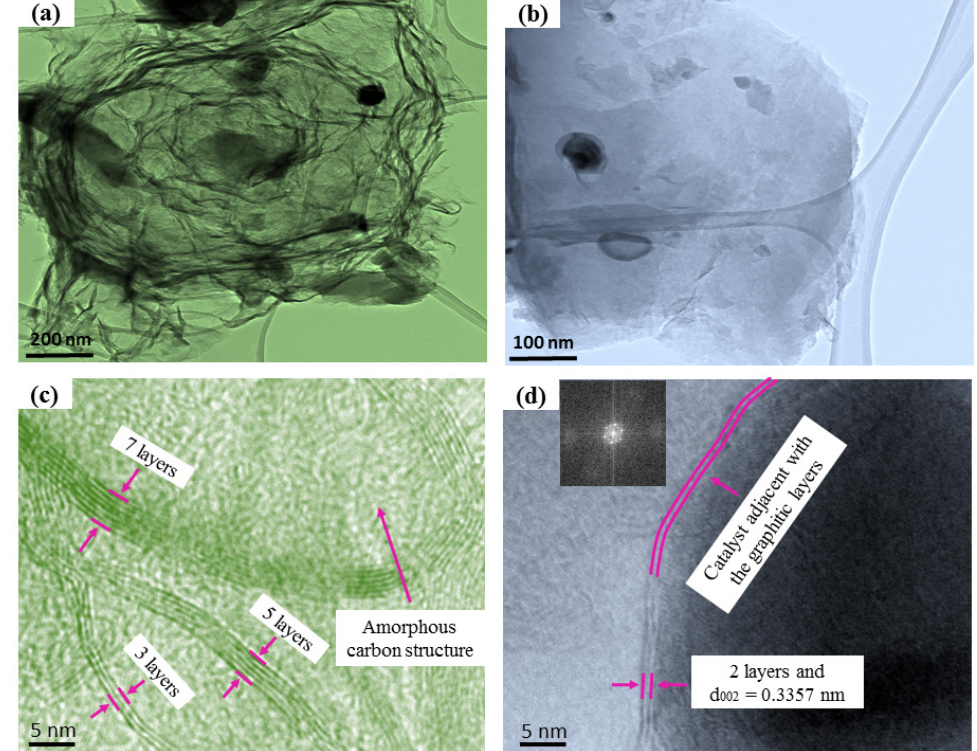
Figure 6. ( a ) and ( b ): TEM of the P10% sample with different magnifications. ( c , d ): the HRTEM showing the FLG sheets (and the FFT image in the inset of ( d )).